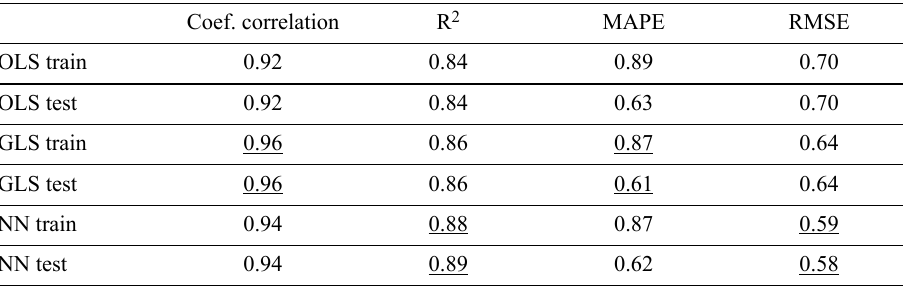
Table 2. Results for simple subjective MCI